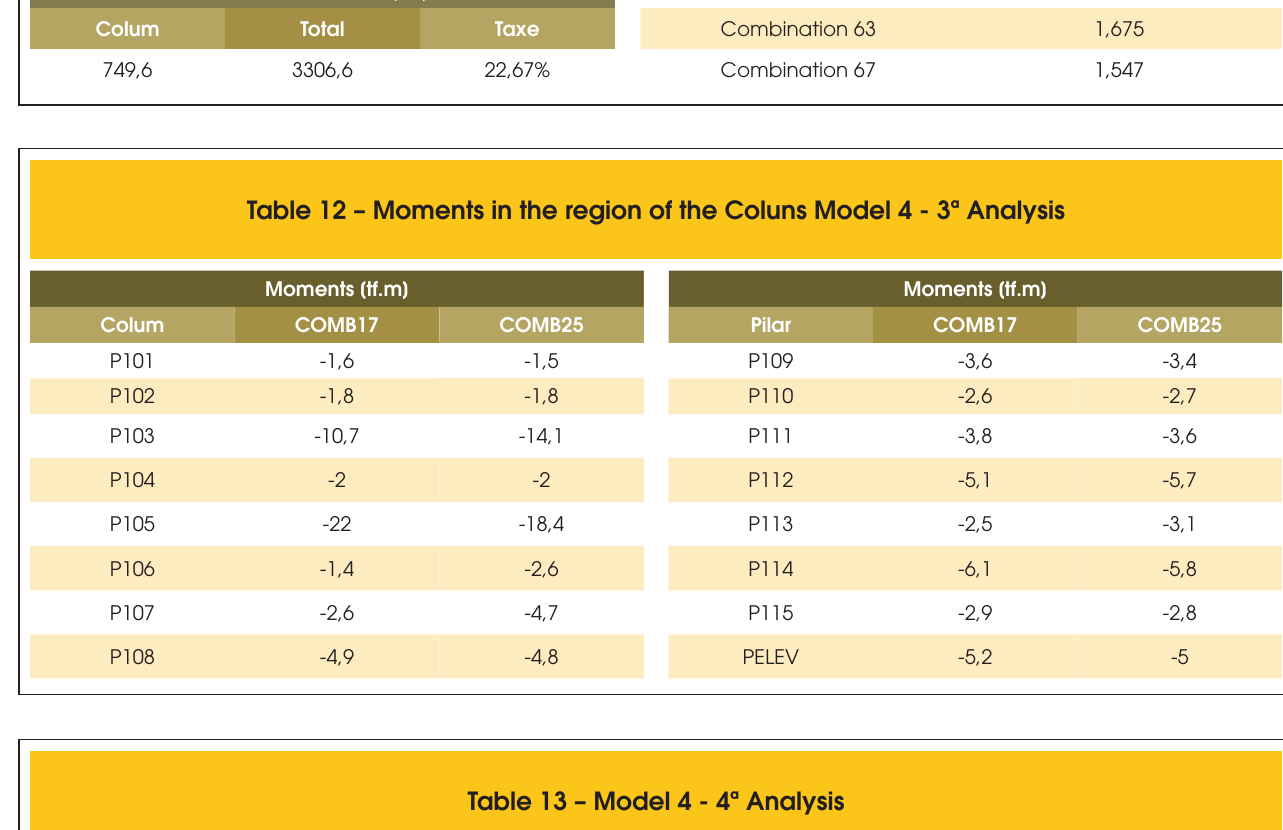
Table 13 – Model 4 - 4ª